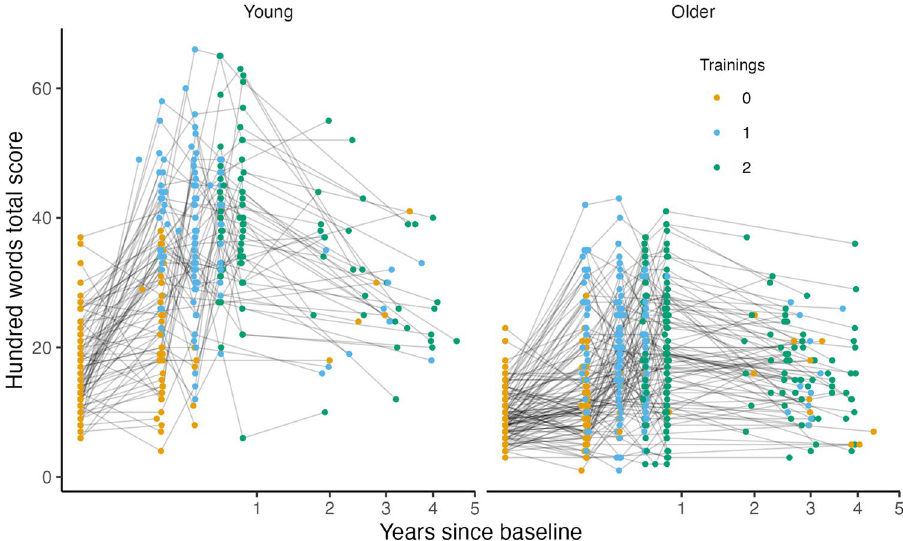
Figure 2. Scores on the 100-words task. The labels show the number of training periods (black = 0, orange = 1, blue = 2) each participant has completed at the given time point, and repeated measurements of a single individual are connected with gray lines. Lines between time-points during the training intervention (within the 1st year) are stretched horizontally, while lines years after cessation (long-term passive period) are compressed for illustrational purposes.